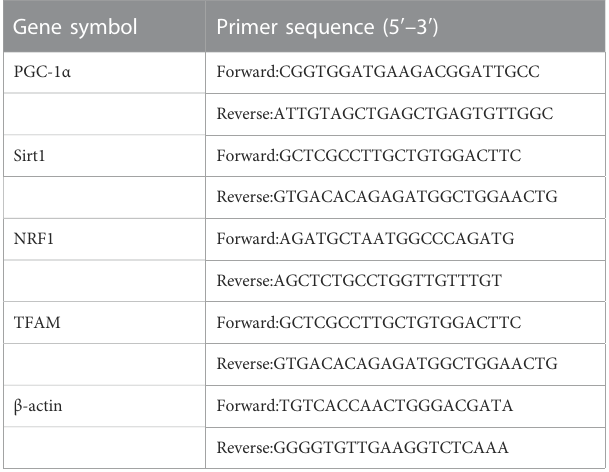
TABLE 1 Primer sequences used for the